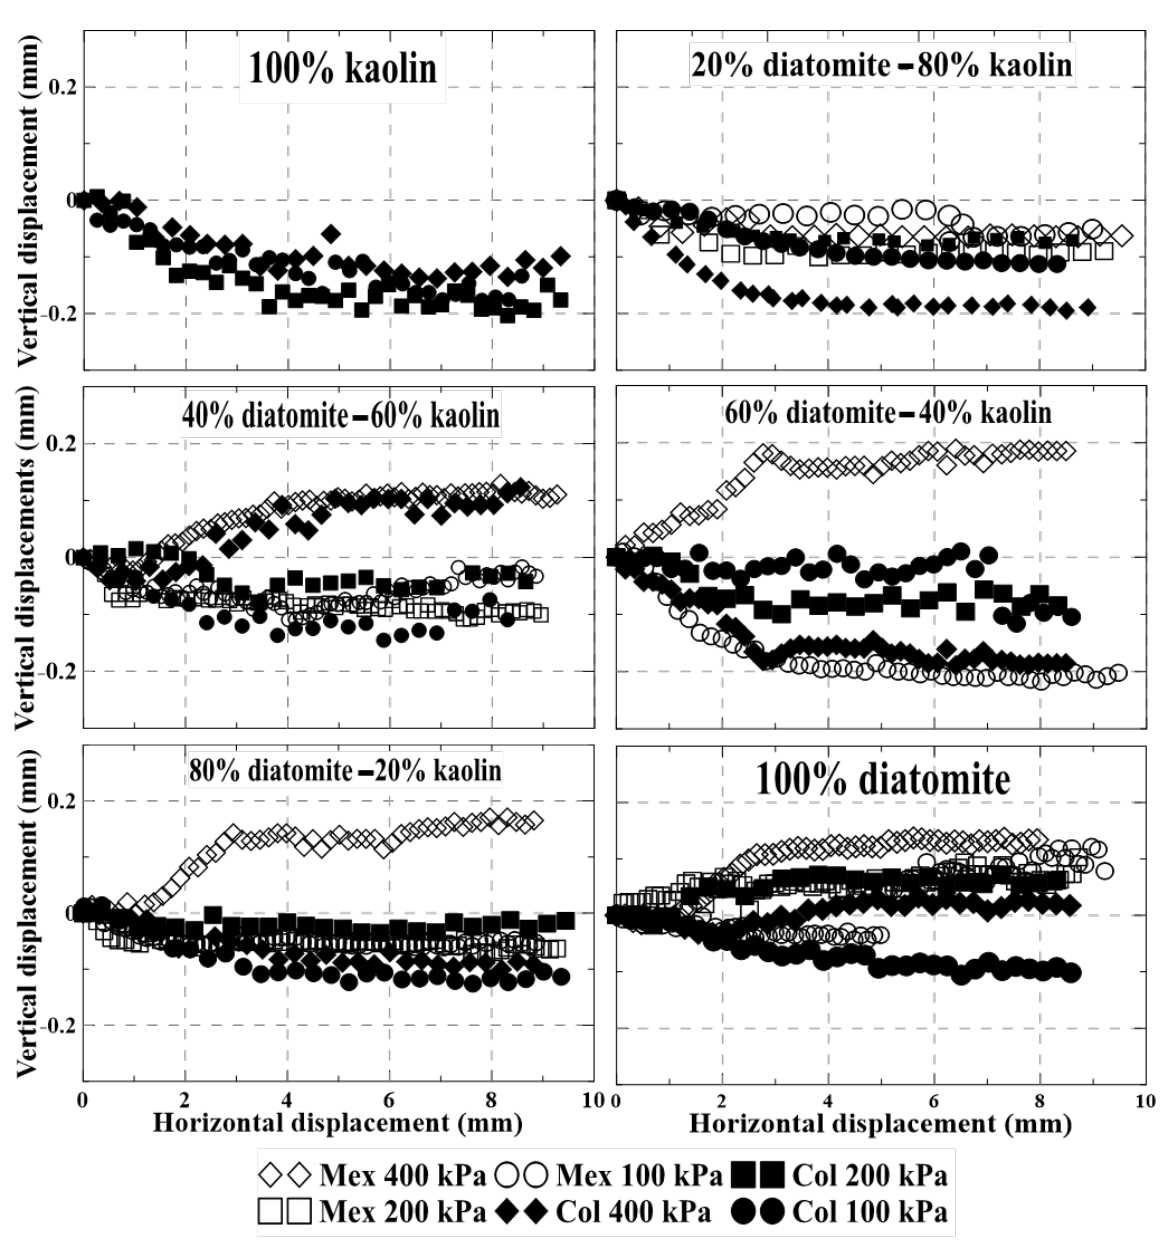
Figure 6. Vertical vs. horizontal displacement for both species analyzed at 60% diatomite content. The same phenomenon was more noticeable in the diatomite-kaolin mixtures manu- factured with Mexican diatomite content equal to or greater than 40%, where the behavior at stresses of 400 kPa was always revealing dilatancy. This may have been influenced by the microstructural configuration of the Mexican diatomite where the discs present could interlock more easily than the cylinders shown by the Colombian species. This is consistent with what has been found in previous studies [21]. In samples prepared with 100% diatomite, the dilatancy was also observed at a medium normal stress (e.g., 200 kPa) for both species. Therefore, it could be believed that, when the specimen has the presence of only diatomaceous material, the behavior is more similar to a dense or compacted granular material. Figure 7 reveals the failure envelopes obtained from the annular shear strength test for the peak shear strength resistance for both diatom microfossil species. With respect to the modified mixtures with Colombian diatomite, at low normal stresses, the shear